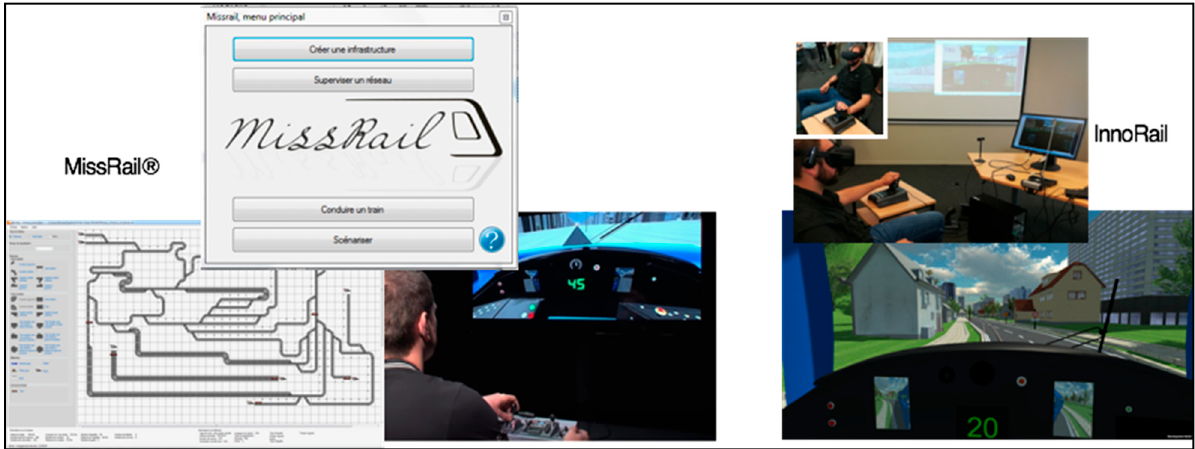
Figure 6. MISSRAIL ® interface for rail simulation.